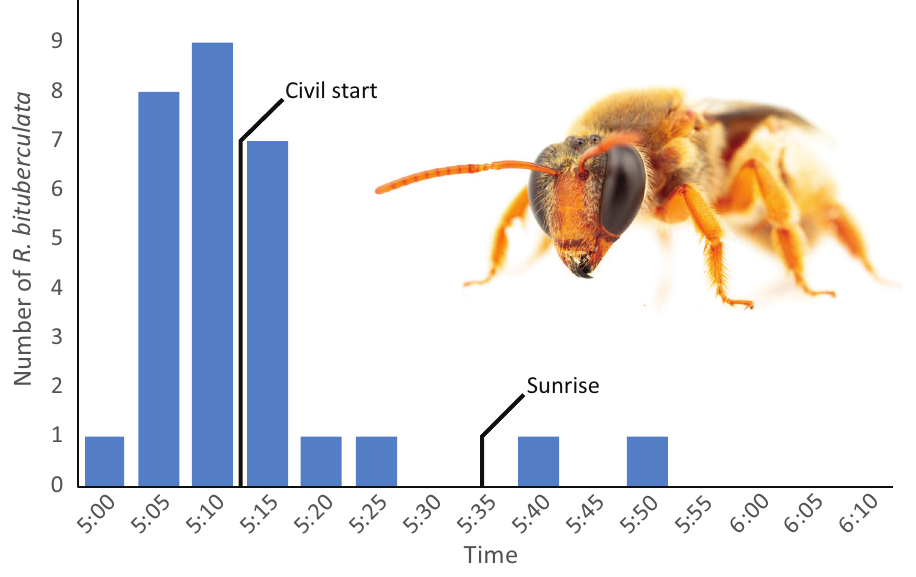
Figure 3. Number of Reepenia bituberculata on Dypsis lutescens palm flowers on the observed tree at the start of every five minute period on the morning of 17 Nov 2019. Civil start and sunrise are indicated by black vertical lines. Bee image is a female R.